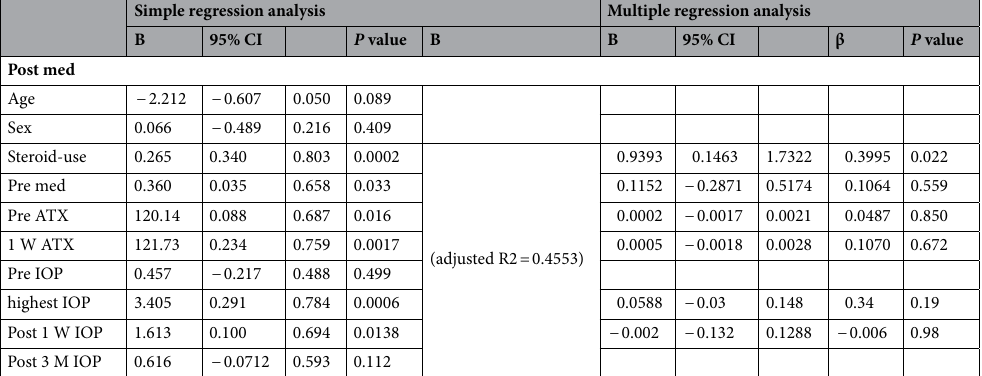
Table 2. Regression analysis of factors associated with the number of postoperative medications. B = regression coefficient or partial regression coefficient. 95% CI = 95% confidence interval of partial regression coefficient. β = standardized partial regression coefficient. adjusted R2 = adjusted coefficient of multiple determination.